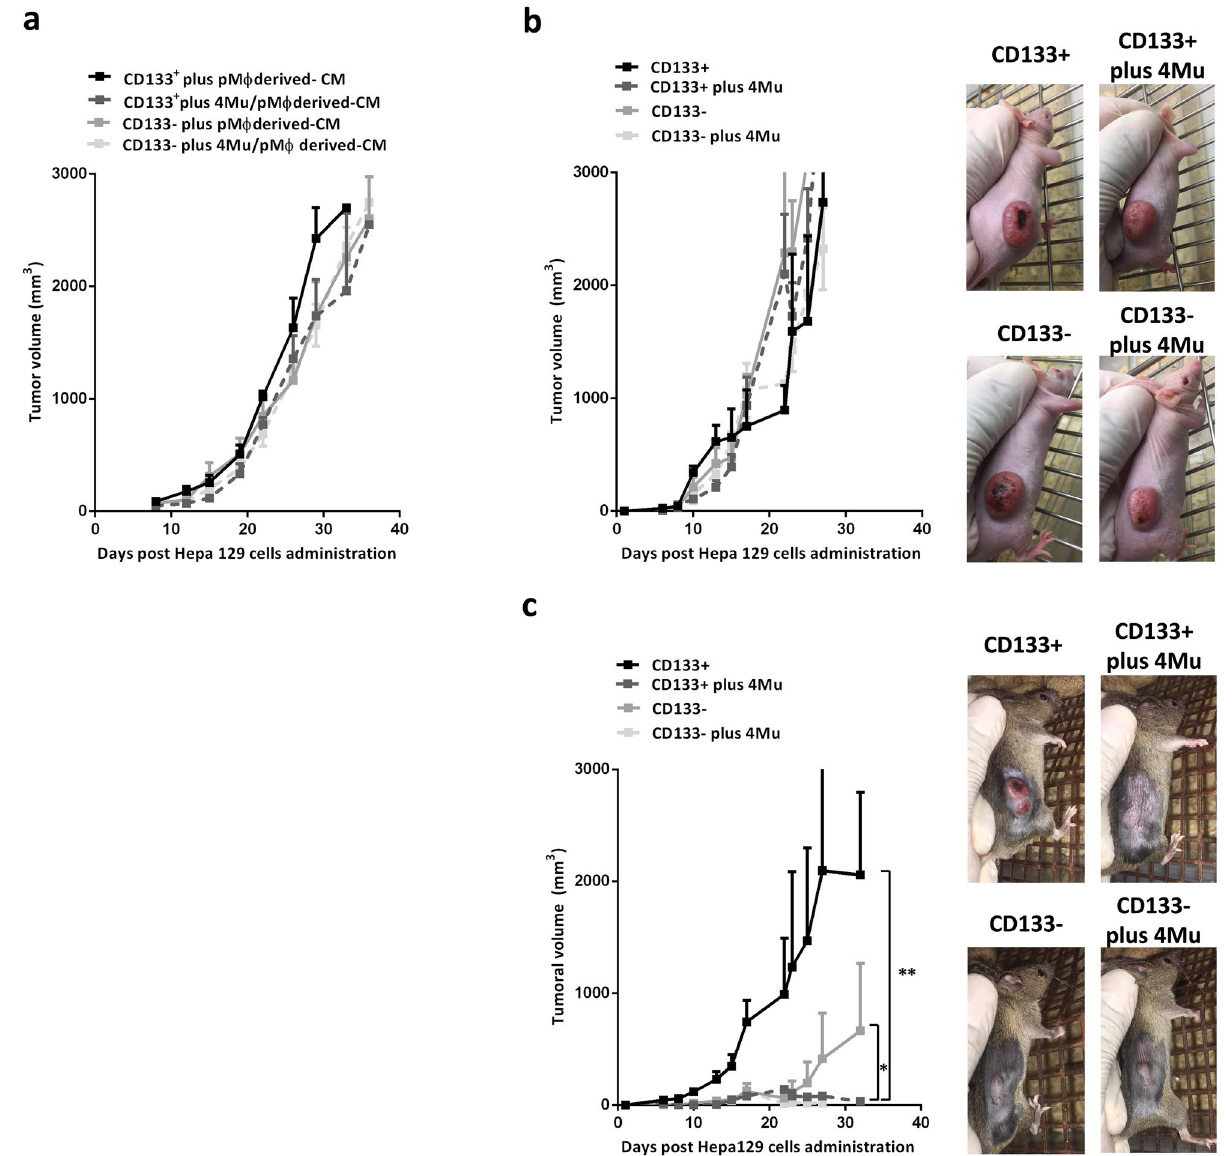
Figure 4. 4Mu and M1 hepatic macrophages facilitate immune recognition of CD133 + HCC cells, and promote antitumor response. ( a ) Hepa129 cells were incubated for duplicate with RPMI (Hepa129 + RPMI), CM from isolated pM (Hepa129 + pM -derived CM) and CM from isolated pM in vitro treated with 4Mu (Hepa129 + 4Mu-treated pM -derived CM) for 48 h. Pre-conditioned 1 × 10 6 Hepa129 cells were ϕ ϕ ϕ injected s.c. in Nu/Nu mice (n = 4/group), and tumor volume was measured. ( b ) Nu/Nu mice (n = 4) and ϕ ( c ) immunocompetent C3Hj mice (n = 4) were injected s.c. with 1 × 10 5 CD133 + Hepa129 cells, 1 × 10 5 4Mu-treated CD133 + Hepa129 cells, 1 × 10 5 CD133-Hepa129 cells, and 1 × 10 5 4Mu-treated CD133- Hepa129 cells. Tumor volume was monitored by caliper. **p < 0.01 CD133+ vs. 4Mu-treated CD133+; *p < 0.05 CD133- vs. 4Mu-treated CD133+; Tukey’s multiple comparisons test. Data are expressed as the mean ± SEM. The experiment was carried-out 2